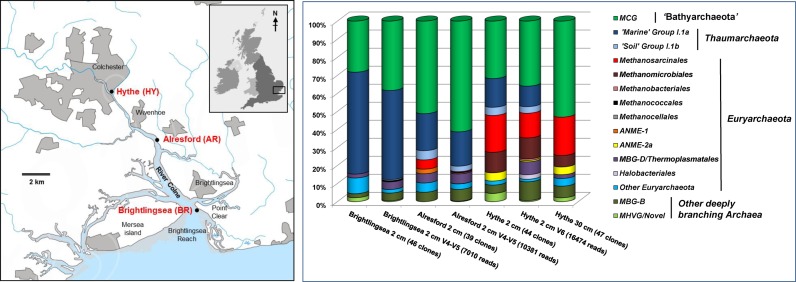
Archaea populations in the River Colne Estuary, UK, sediments change with increasing salinity gradient from populations dominated by methanogenic Euryarchaeota and ‘Bathyarchaeota’ (MCG) in brackish sediments to putatively ammonia-oxidizing Thaumarchaeota and MCG in marine sediments.